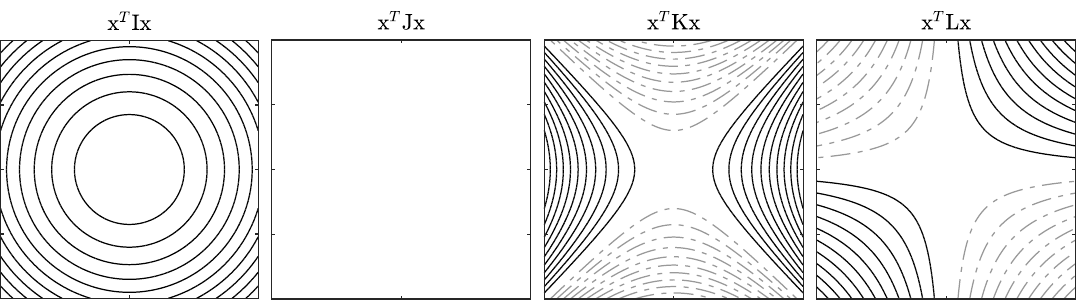
Figure 2. Quadratic forms associated with the IJKL matrices. From left to right, contour plots of x T Ix , x T Jx , x T Kx , and x T Lx are shown, with positive contours shown as black solid lines and negative contours as dashed-dotted gray lines. Note that x T Jx = 0